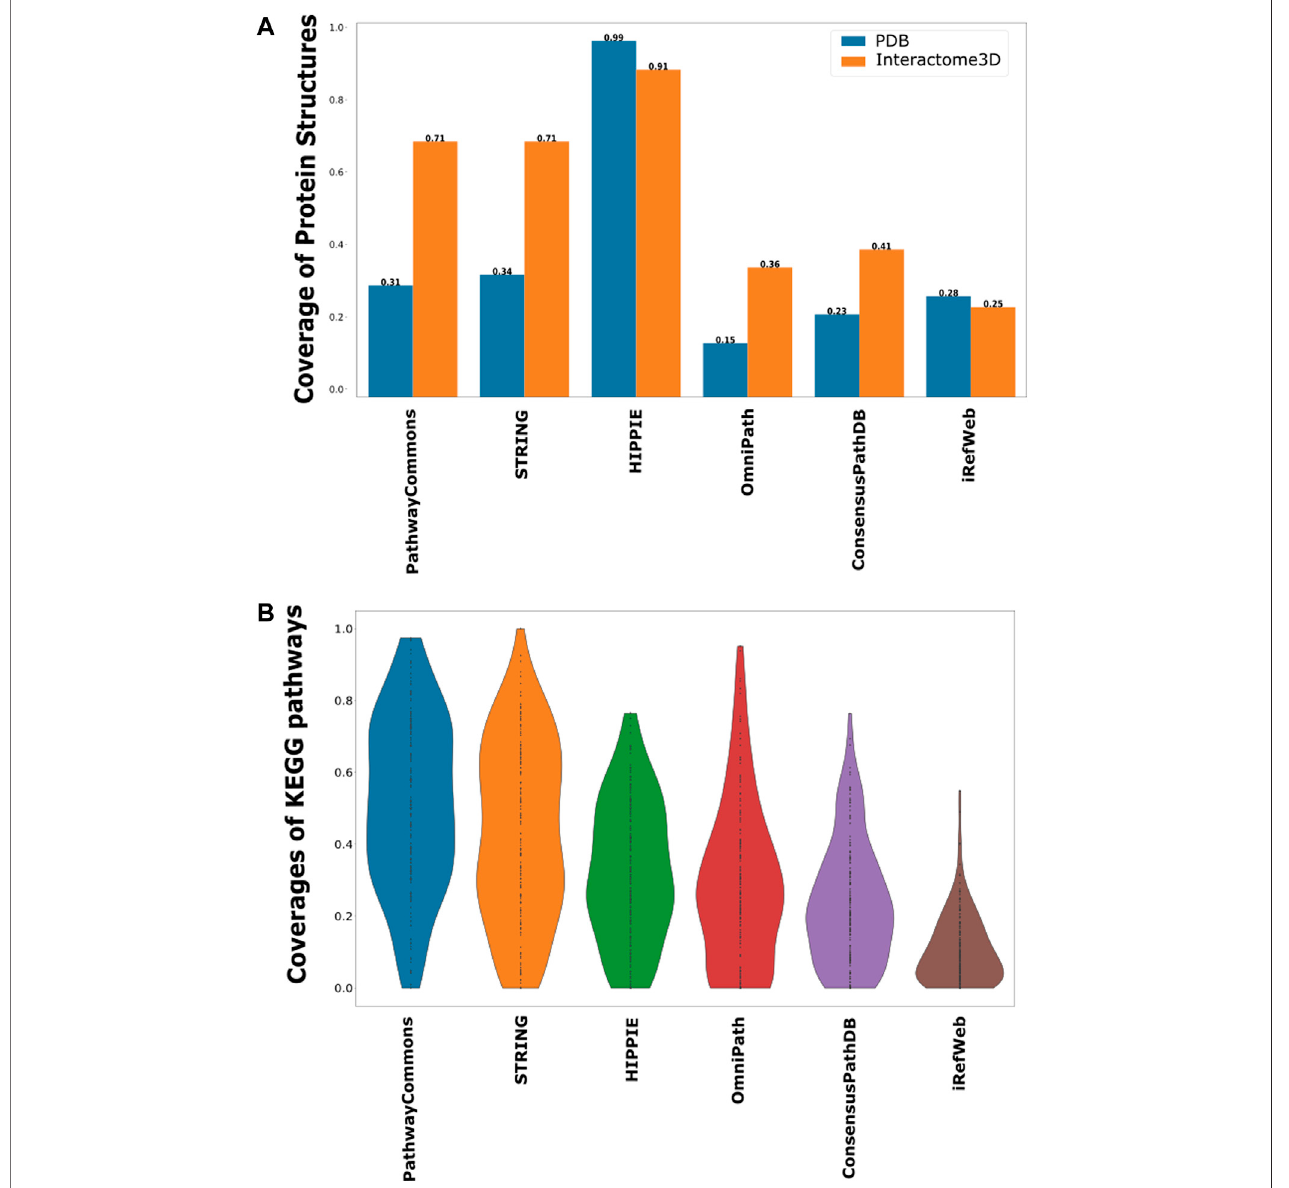
FIGURE4| Coverageofstructurallyknowninteractionsandpathwayinteractionsineachinteractome. (A) Structuralinformationisdemonstratedintwogroups,as known interactions in PDB in blue and predicted interactions in Interactome3D in orange. (B) Overlaps between the interactions in KEGG pathways and each interactome are shown as a